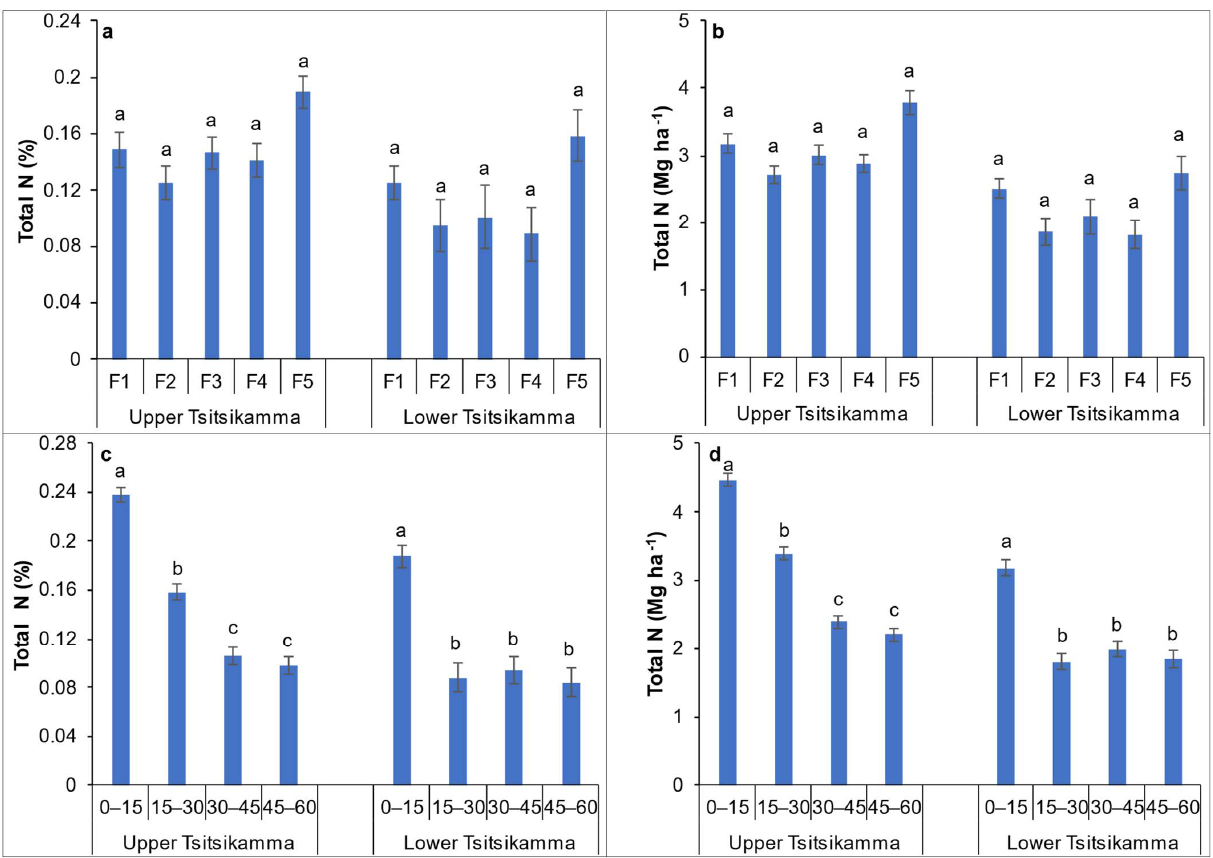
Figure 4. Effects of different farm management ( a , b ) and soil depth ( c , d ) on total N contents ( a , c ) and stocks ( b , d ) under mixed pastures in the Tsitsikamma dairy farms. Error bars indicate standard error of means. Different letters per site indicate significant difference.